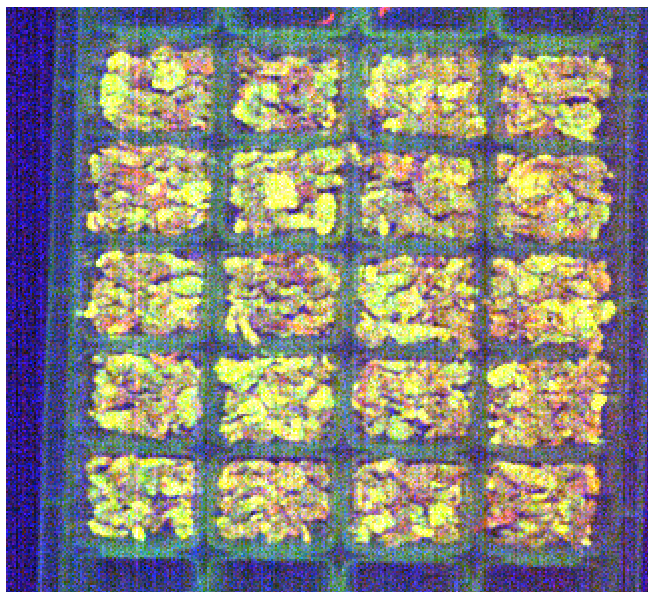
Figure 2. Fluorescence hyperspectral image of tea.